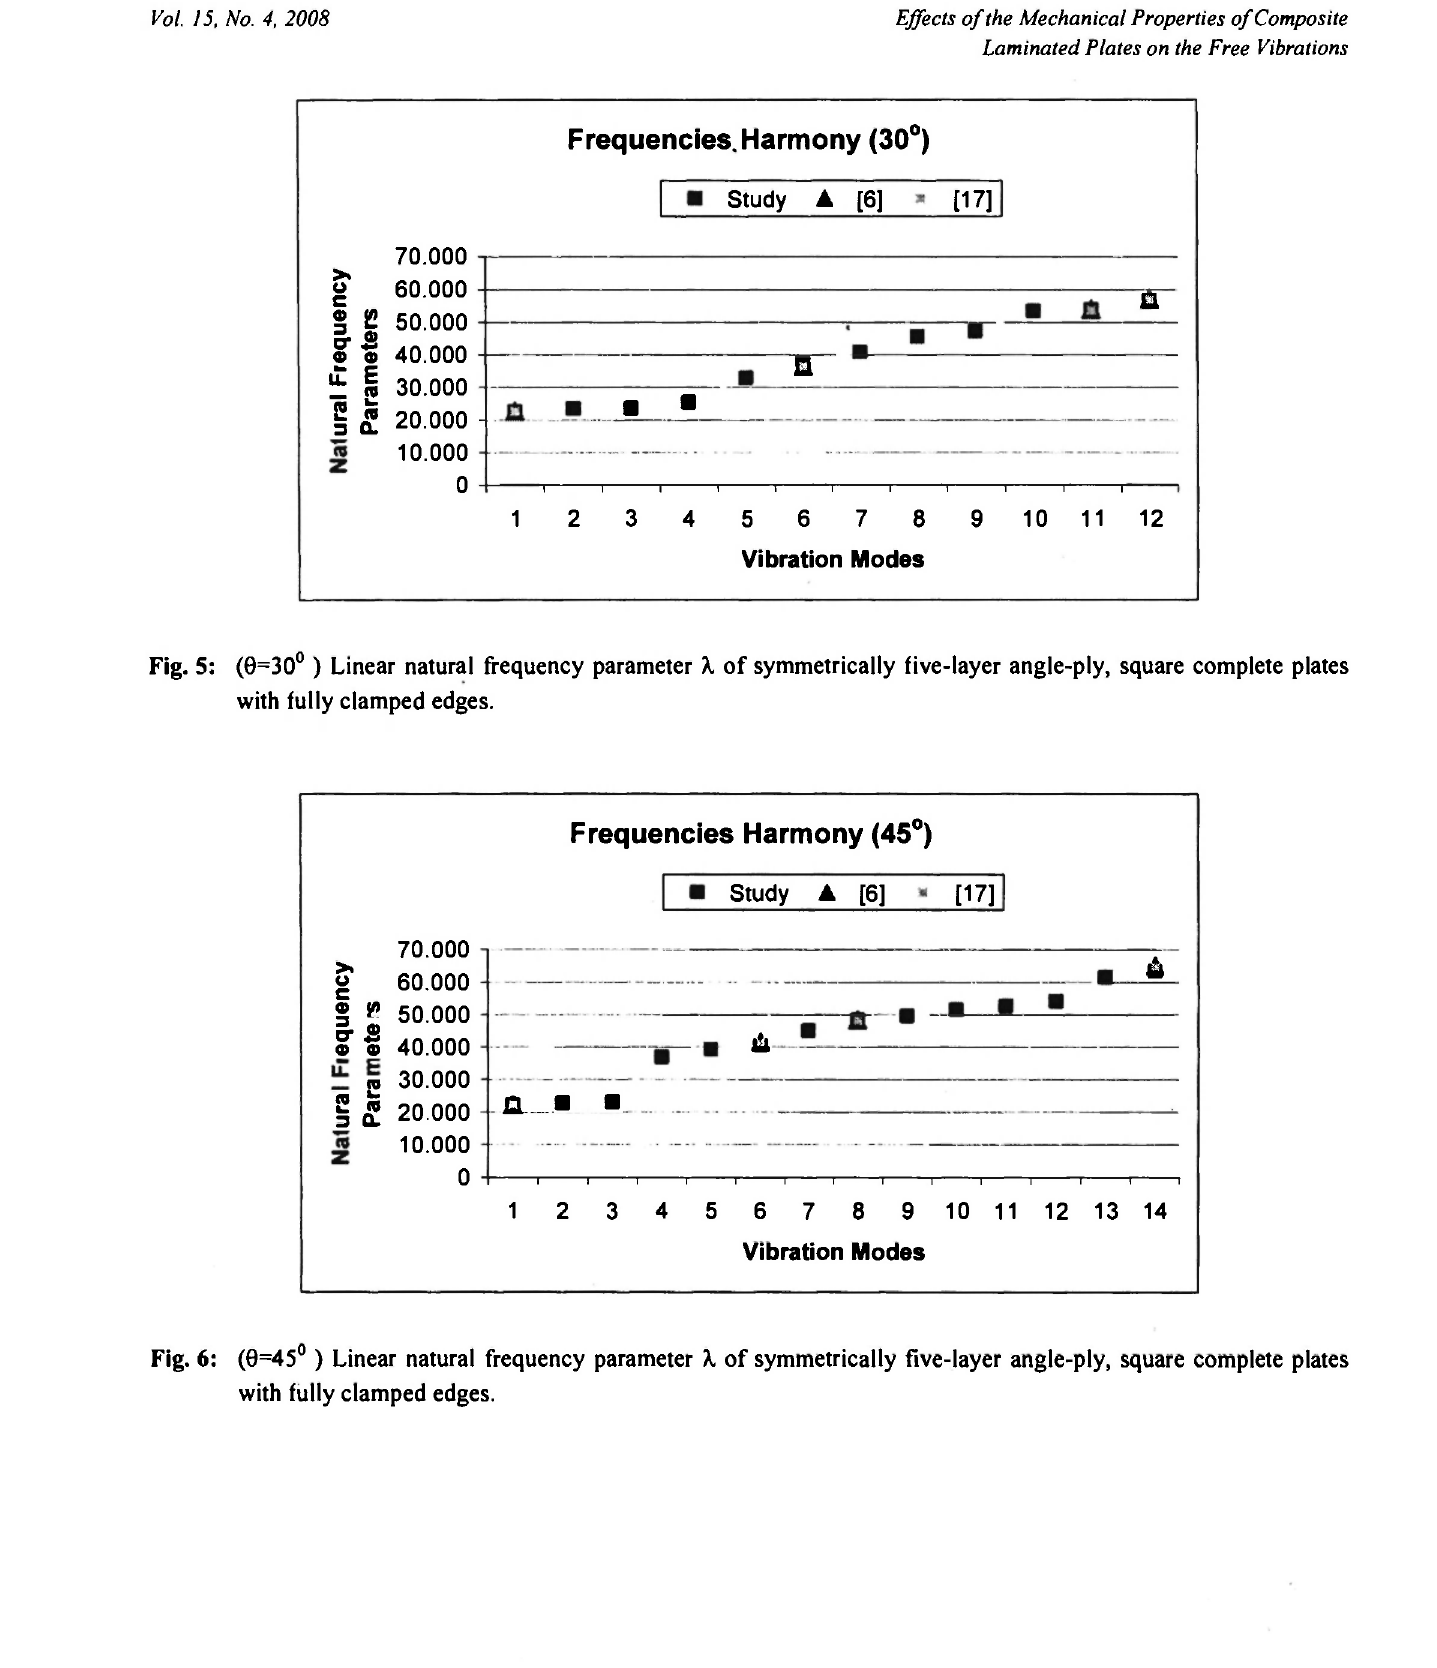
Fig. 6: (θ=45° ) Linear natural frequency parameter λ of symmetrically five-layer angle-ply, square complete plates with fully clamped